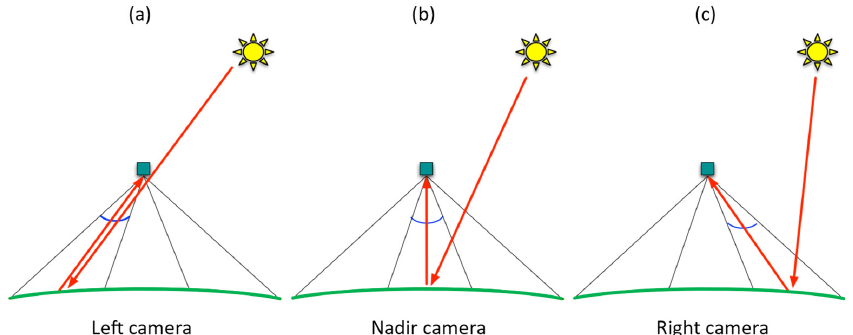
Figure 1. The figure presents a simplified scheme of Proba-V across-track observation geometry, which is composed of three overlapping cameras arranged in a fan-shaped configuration. The geometry of observation in three cameras is presented in the panels: ( a ) left camera, ( b ) nadir camera, ( c ) right camera. The position of the sun is simplified for the sake of clarity, although the basic angular configuration of the descending morning orbit is maintained, meaning the left camera is looking westward, away from the sun, with prevalence of backscattering conditions, while the right one is looking eastward, towards the sun, with prevalence of forward scattering. Proba-V products are released to the users as segments per camera (L2A) Top-Of- Atmosphere (TOA) product, as well as temporal composites S1 (daily) TOA and S1/S10 (daily and 10 days) atmospherically corrected Top-Of-Canopy (TOC), i.e., surface reflec- tance products [18]. The data are projected onto the Plate Carrée grid, and provided at 1 km, 333 m and 100 m spatial resolution. The cloud detection is based on a dynamic thresh- old method [18]. The cloud shadow pixels are flagged using a hybrid radiometric and geometric approach, while the snow/ice detection is based on a decision tree algorithm [18]. The atmospheric correction is performed using the Simplified Method for Atmos- pheric Correction (SMAC) approach [19]. The aerosol optical depth (AOD) at 550 nm is estimated using an optimization algorithm applied to the Blue channel over vegetated surfaces [20]; over desert sites and bare soils, a latitude-dependent AOD climatology is used instead.